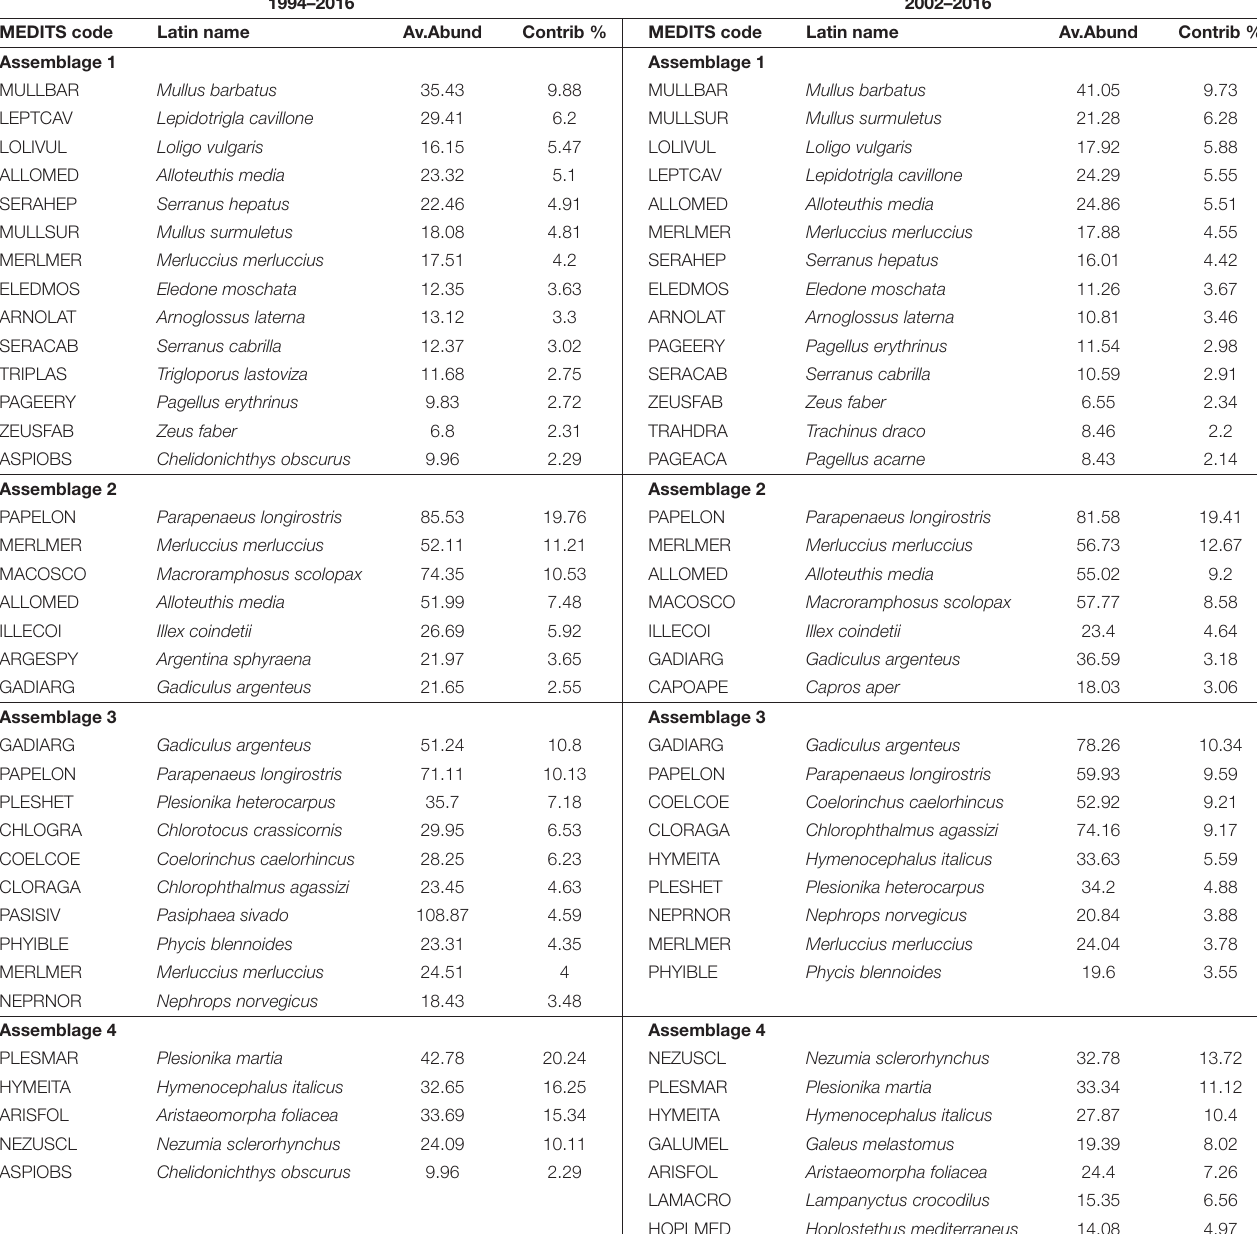
TABLE 3 | Main species that form each assemblage for both time